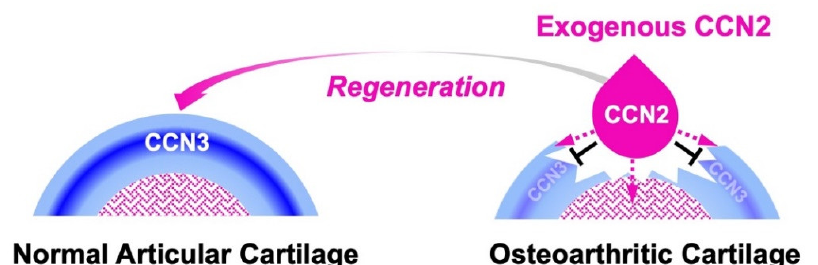
Figure 4. Molecular action of exogenous CCN2 applied to regenerate damaged articular cartilage. Under healthy conditions, CCN3 is produced immediately beneath the superficial zone to maintain the stemness of chondrocytes ( left ). In the articular cartilage degenerated by osteoarthritis ( right ), exogenously applied CCN2 (droplet in pink) releases the articular chondrocytes in the superficial zone from stemness by inhibiting the production of CCN3 and forwards them to cartilage regeneration (black T-bars). CCN2 also stimulates chondrocyte progenitors in bone marrow towards cartilage regeneration (dotted lines in pink).